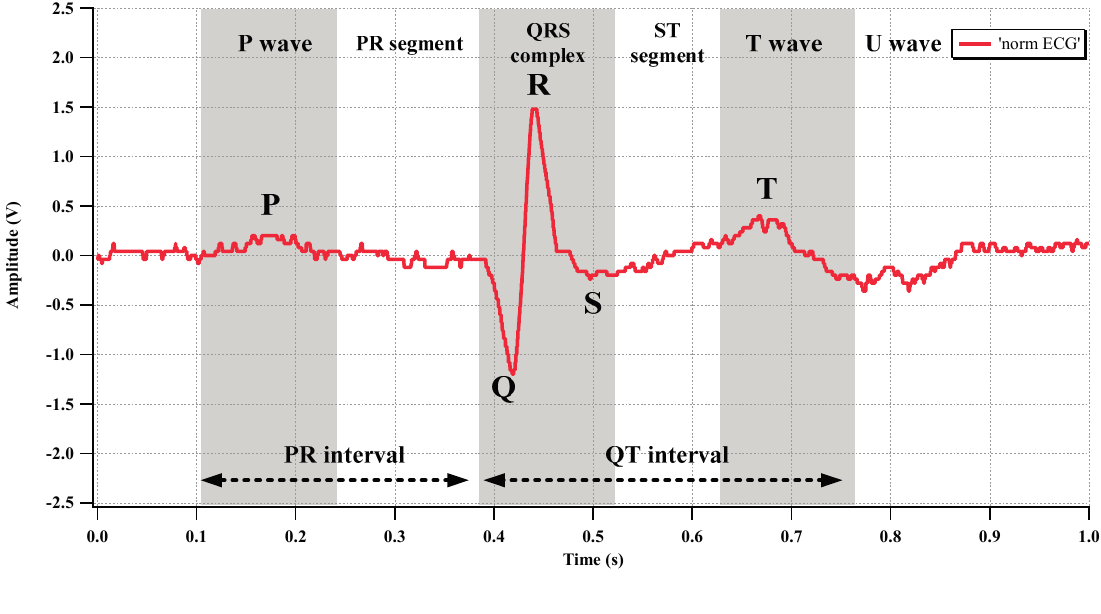
Figure 19. Measured ECG